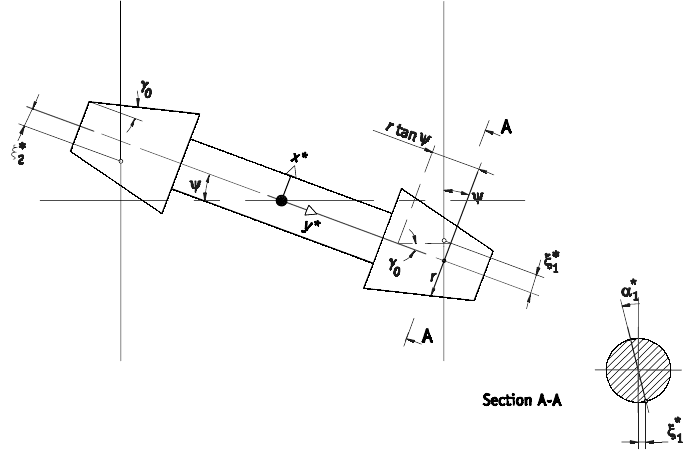
Fig. 3. Representation of the first order term of the contact point shift ξ ∗ and of the contact shift angle α ∗ for ϕ = 0 and R R = 0